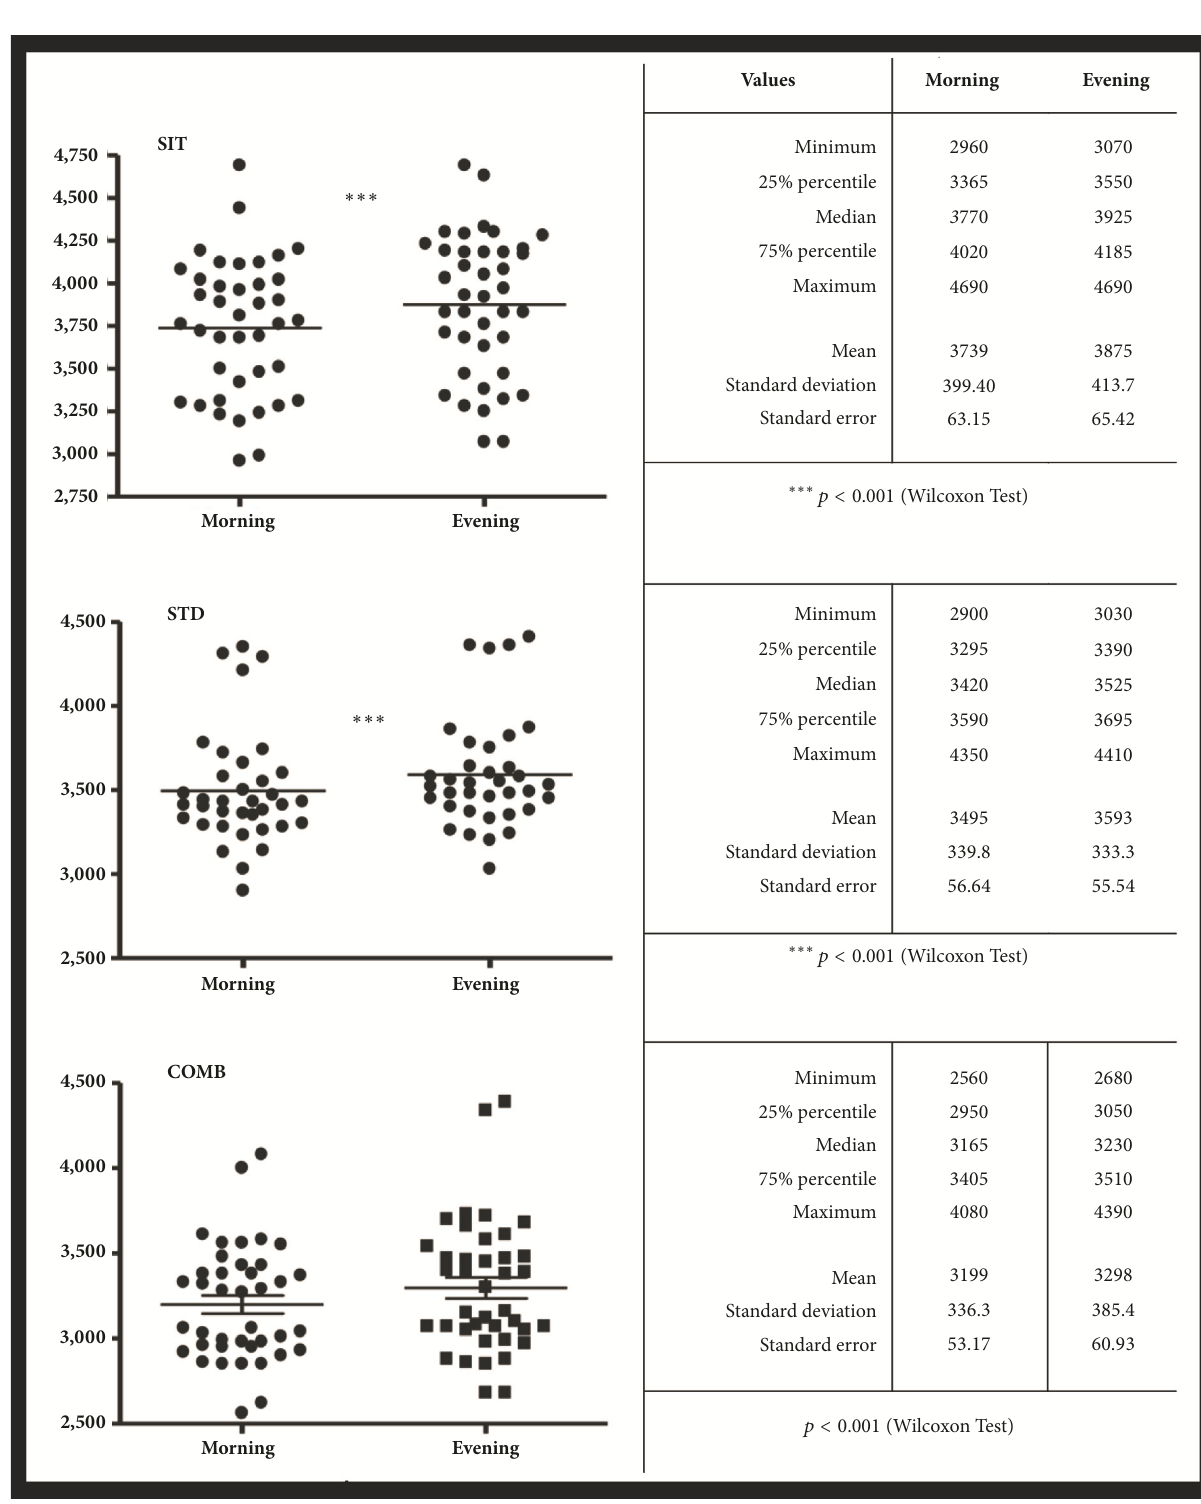
Figure 1: Volumetric (milliliters) measures taken on the first day (without stockings) at morning and at evening in the three posture